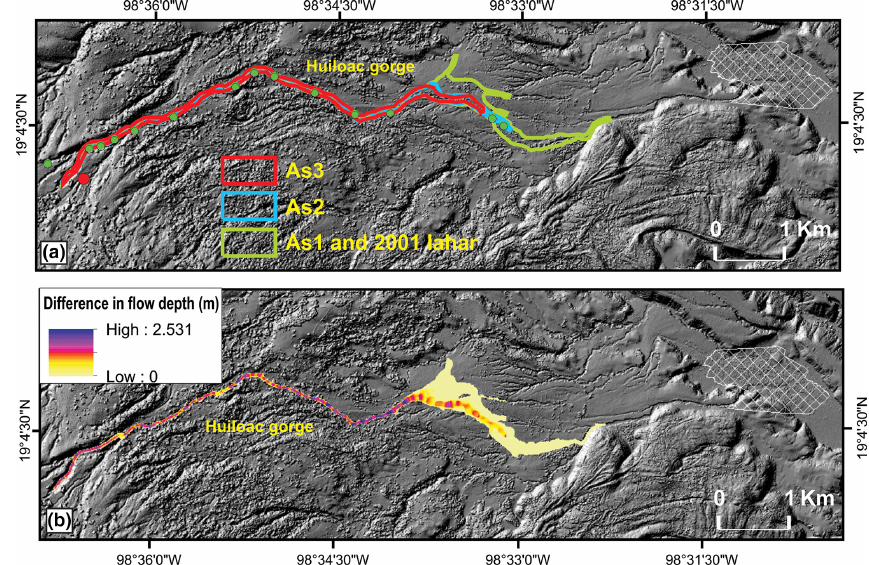
Figure 9. Comparison of the alternative scenarios with the 2001 lahar simulation. (a) Area of inundation. (b) Difference in lahar flow depth (m) between the different alternative